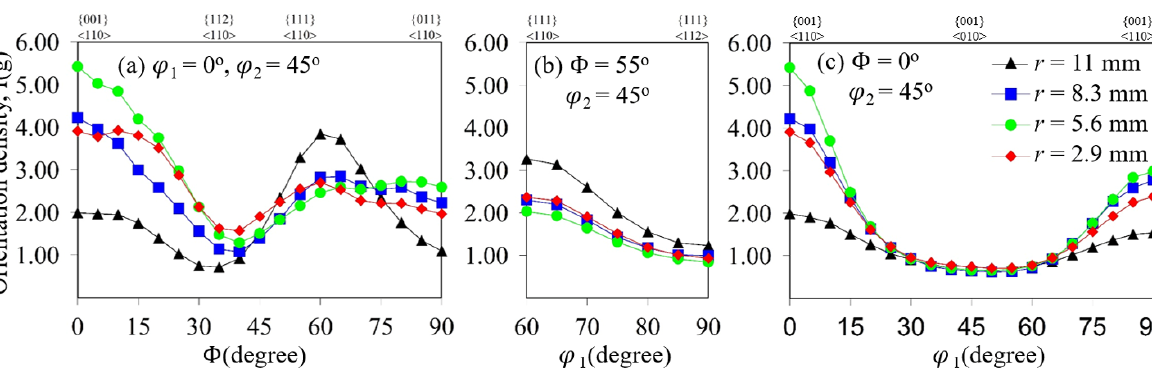
Figure 9. The 45 ◦ ODF diagrams of the forged tube with a reduction of 42.7%: ( a ) r = 11.0 mm; Figure 9. The 45° ODF diagrams of the forged tube with a reduction of 42.7%: ( a ) r = 11.0 mm; ( b ) r ( b ) r = 8.3 mm; ( c ) r = 5.6 mm; ( d ) r = 2.9 mm. = 8.3 mm; ( c ) r = 5.6 mm; ( d ) r = 2.9 mm.